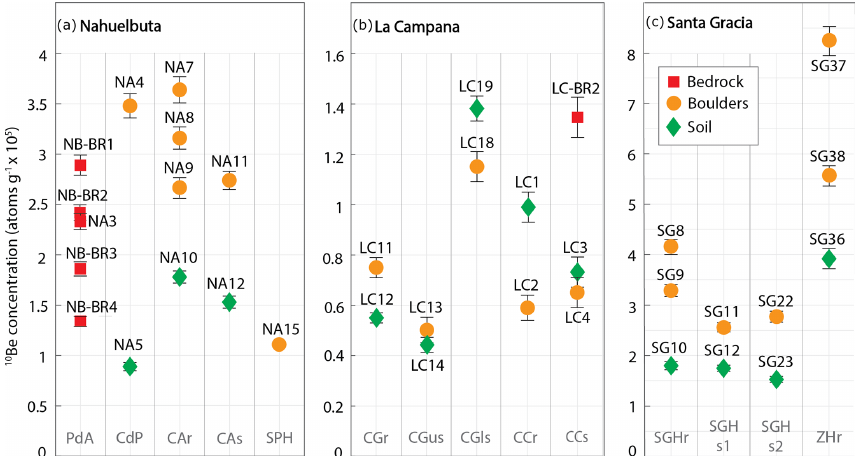
Figure 4. Measured 10 Be concentrations normalized to reference production rate at sea level high latitude for (a) Nahuelbuta, (b) La Cam- pana, and (c) Santa Gracia; note the different scales of y axes. The x axes are not numerical but rather show the sampling locations, also reported in Table 1. Labels next to data points provide sample IDs, also reported in Table 1. Gray labels at the bottom of panels are the sam- ple locations. PdA: Piedra de Aguila, CdP: Casa de Piedas, CAr: Cerro Anay ridge, CAs: Cerro Anay slope, SPH: Soil Pit Hill, CGr: